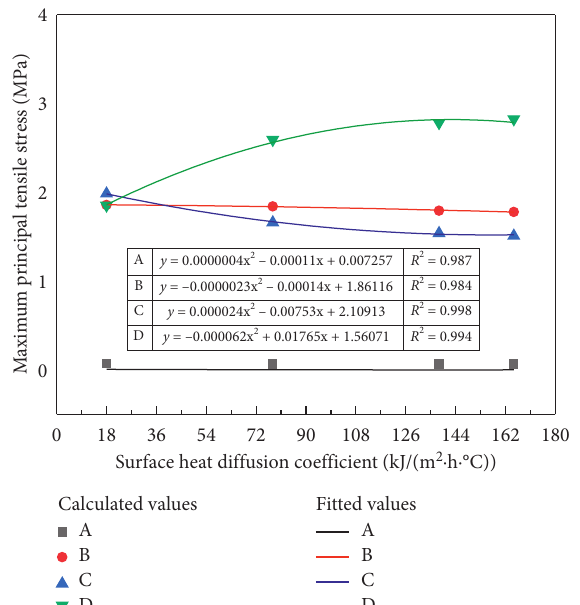
Figure 9: The calculated and fitted maximum principal tensile stress at each point with a different surface heat diffusion